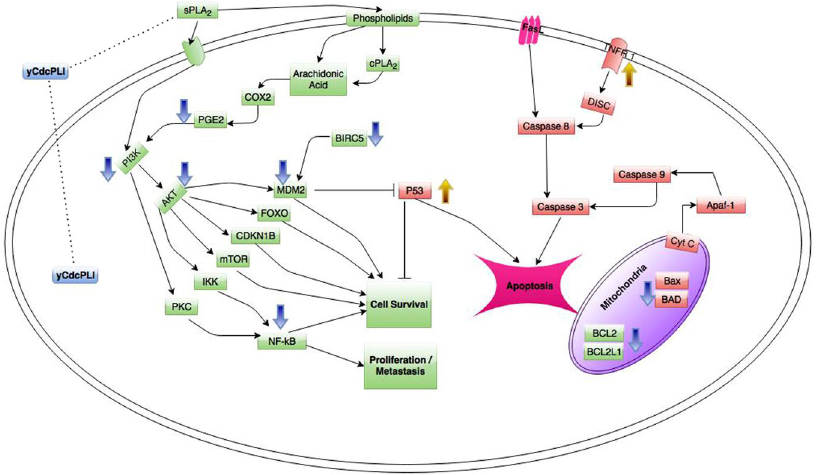
Figure 8. Representative model of some signaling pathways in a human breast cancer cell (MDA-MB-231) that can be modulated by γ CdcPLI. The PLA 2 inhibitor interferes in gene expression of different proteins involved in proliferation and metastasis, cell survival and apoptosis signaling pathways. PLA 2 , phospholipase A 2 ; PGE2, prostaglandin E2; COX, cyclooxygenase; PI3K, phosphoinositide-3-kinase; CDKN1B, cyclin-dependent